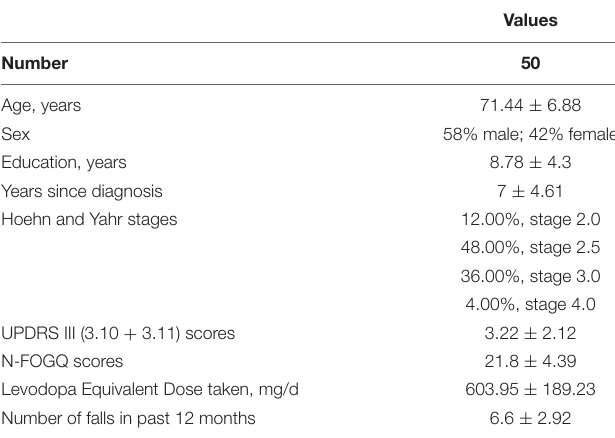
TABLE 1 | Demographics of the subjects. TABLE 2 | Frequency of FOG in 13 PD patients.